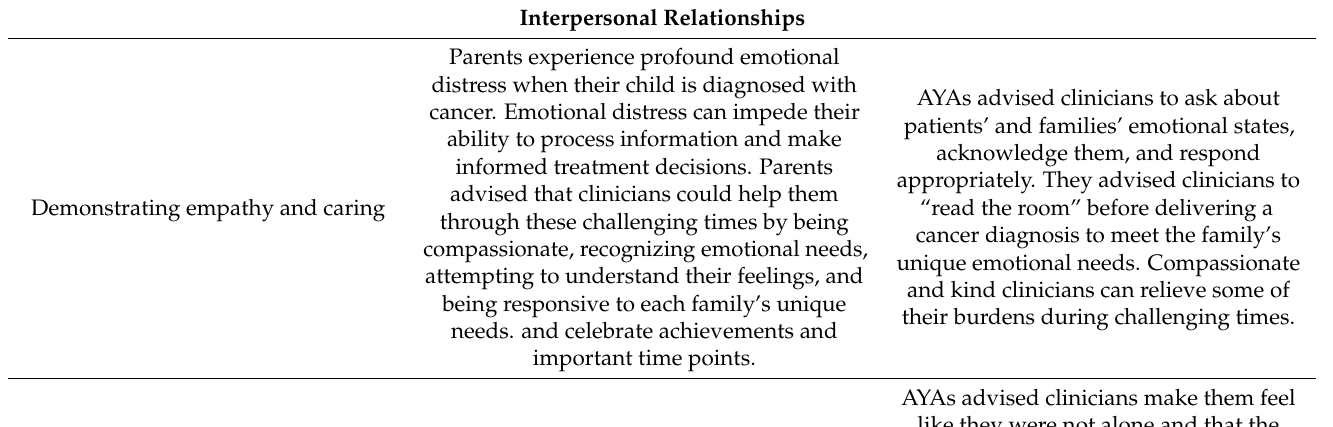
Table 4. Definitions of